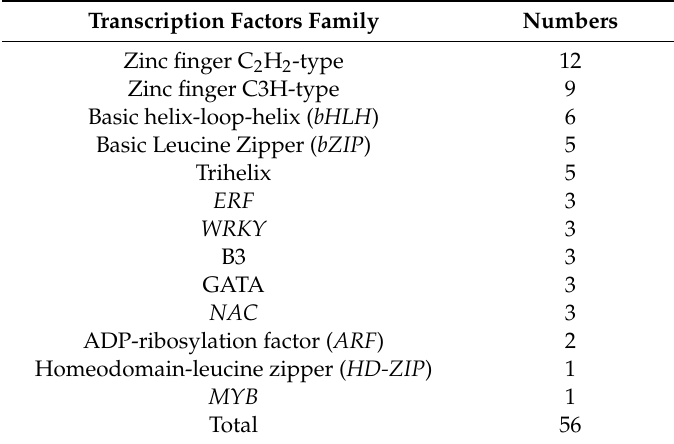
Table 3. Transcription factors identified in the C. velia under Hg